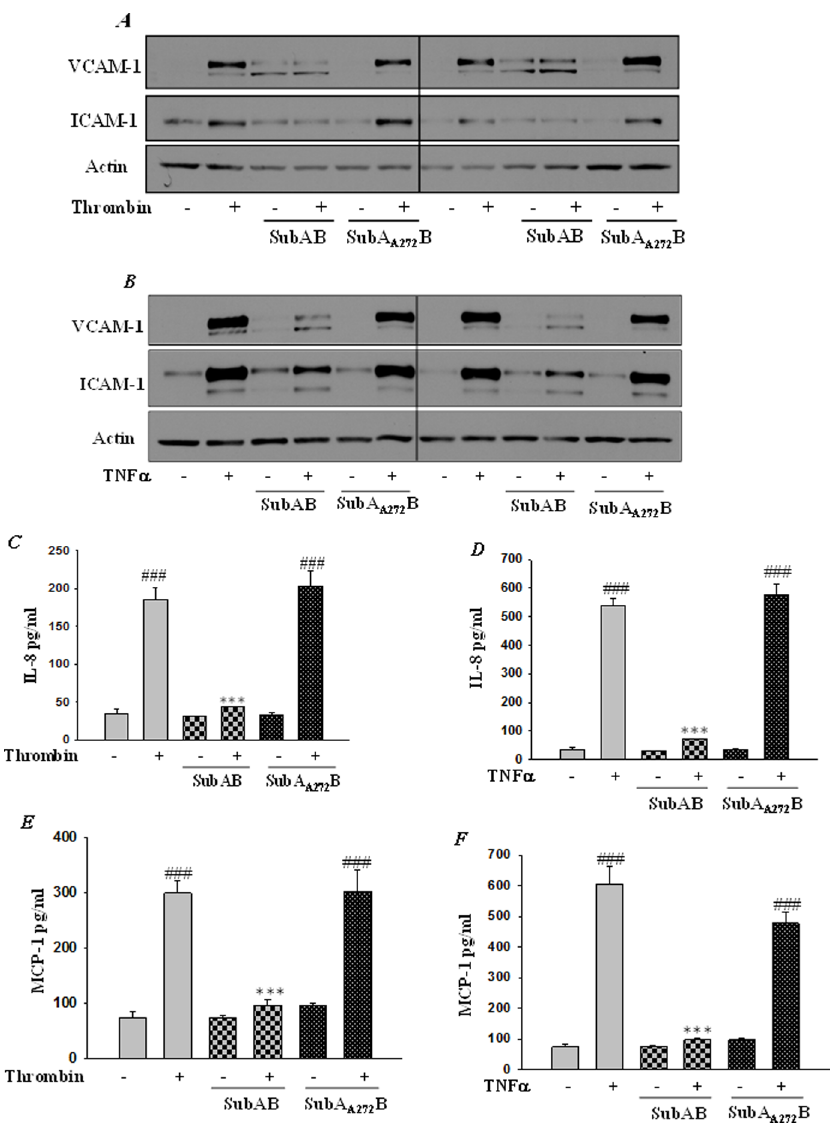
Figure 11. SubAB inhibits NF- k B mediated proinflammatory gene expression. HPAEC were treated with 0.1 m g/ml of SubAB or mutant SubA A272 B for 6 h, followed by treatment with ( A&C&E ) thrombin (5 U/ml) or ( B&D&F ) TNF a (100 U/ml) for 6 h. Total cell lysates were immunoblotted with ( A&B ) anti-ICAM-1 antibody and anti -VCAM-1 antibody. Actin was used to monitor loading . The conditioned media were subjected to ELISA to determine the levels of ( C&D ) IL-8 or ( E&F ) MCP-1. Data are means 6 S.E. (n=6–9 for each condition). ### p , 0.001 difference from control; *** p , 0.001 difference from thrombin and TNF a -stimulated